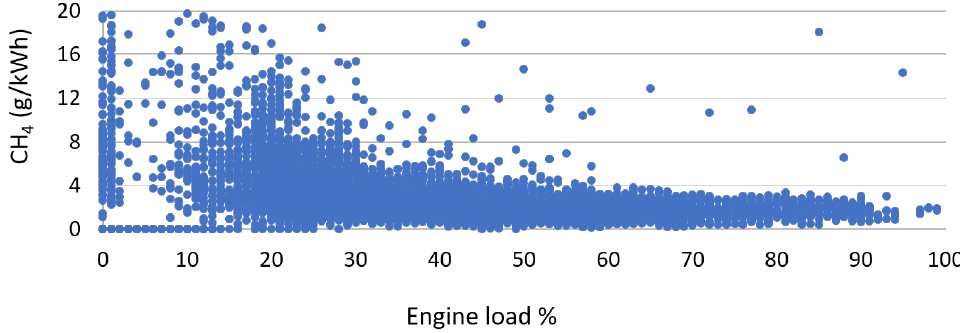
Figure 4. Specific CH 4 and NO x emissions in g/kWh and g/km in hot-start tests.